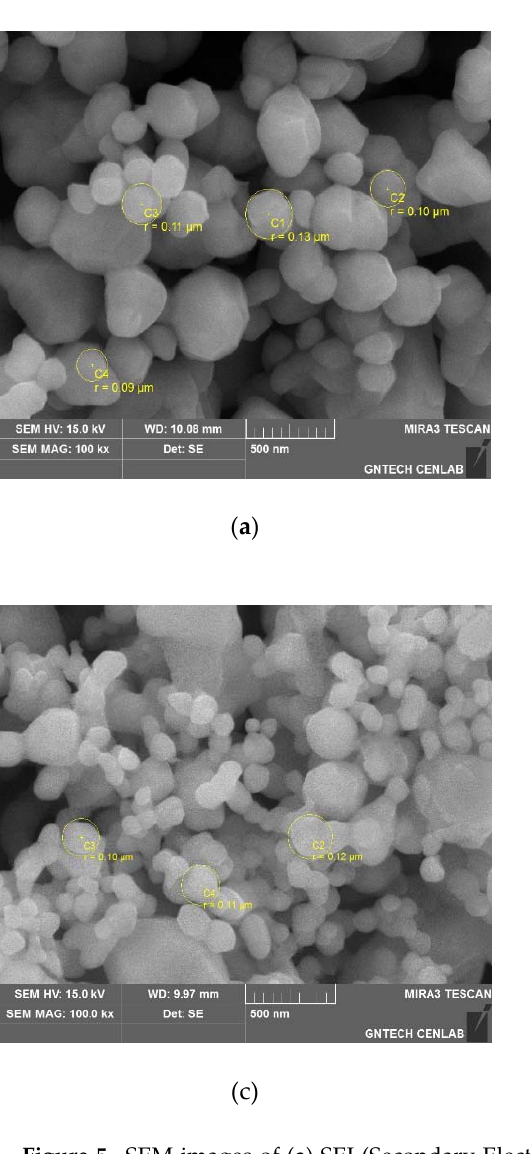
Figure 5. SEM images of ( a ) SEI (Secondary Electron Image) of Cu particles (A), ( b ) EDS (Energy Dispersive Spectrometer) of Cu particles (A), ( c ) SEI of Cu particles (B); ( d ) EDS of Cu particles (B).